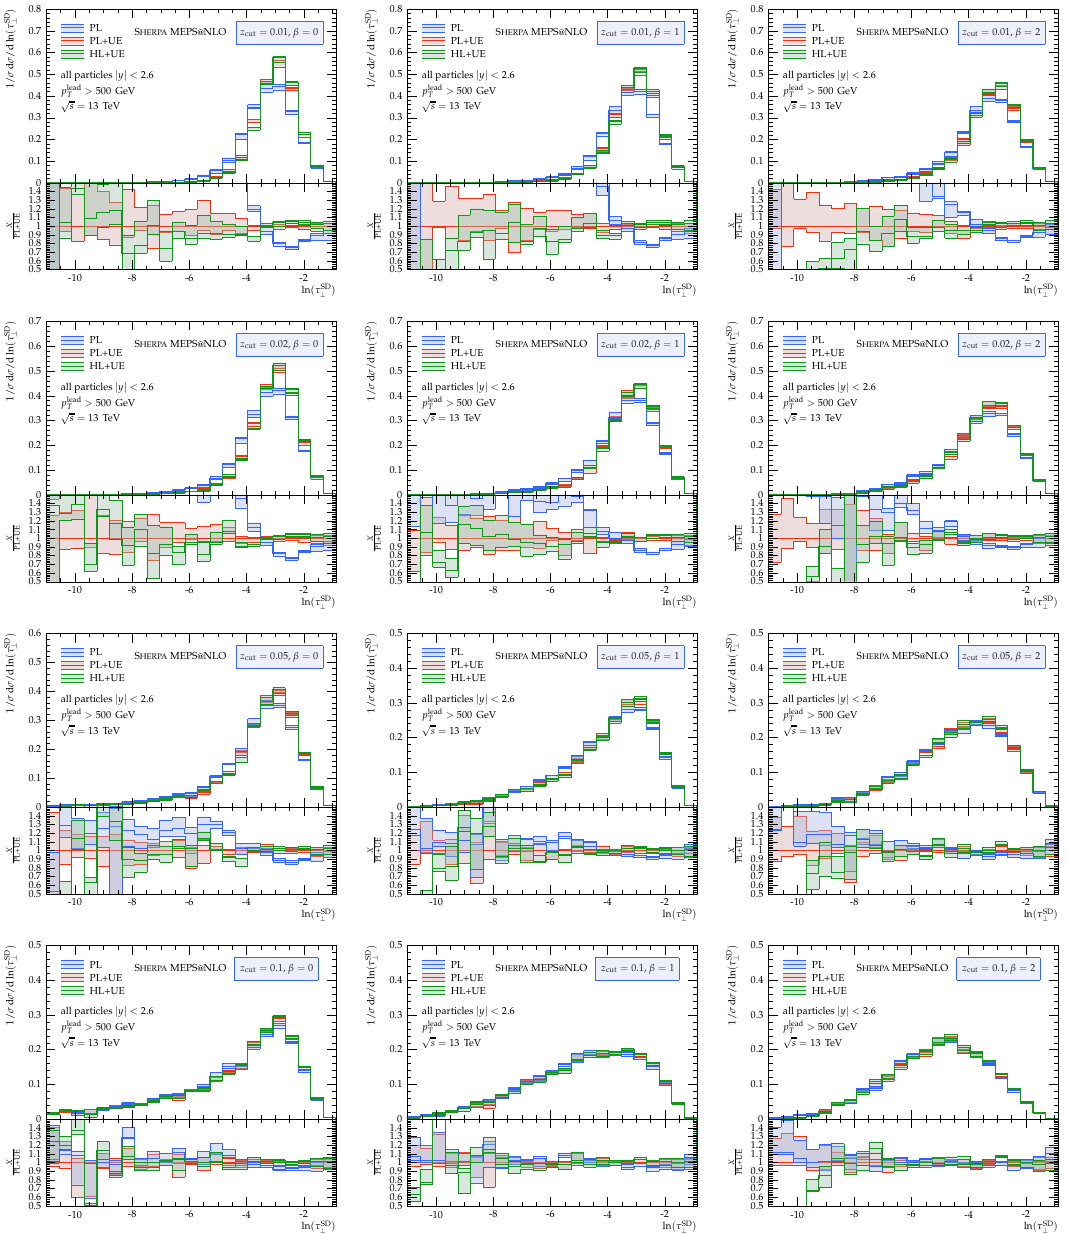
Figure 13 . The groomed thrust distributions for β ∈ { 0 , 1 , 2 } (columns) and z cut ∈ { 0 . 01 , 0 . 02 , 0 . 05 , 0 . 1 } (rows) for the p T, min = 500 GeV event selection. The lower panels show the ratios with respect to the parton-level simulation including the underlying event (PL+UE)